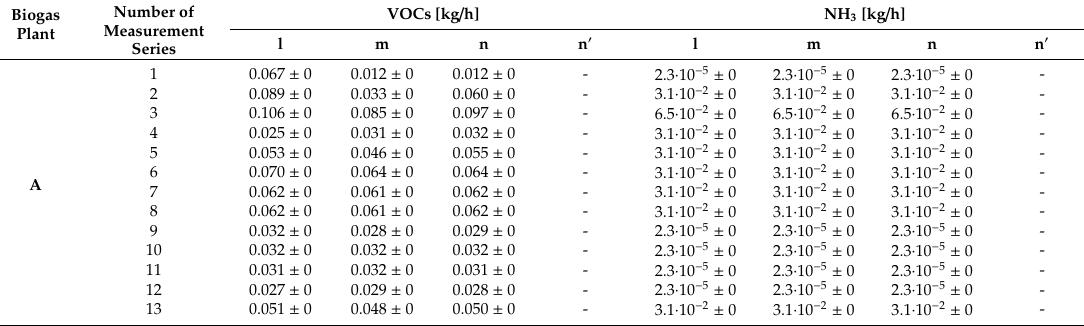
Table 9. Measurement results of the emissions from roof